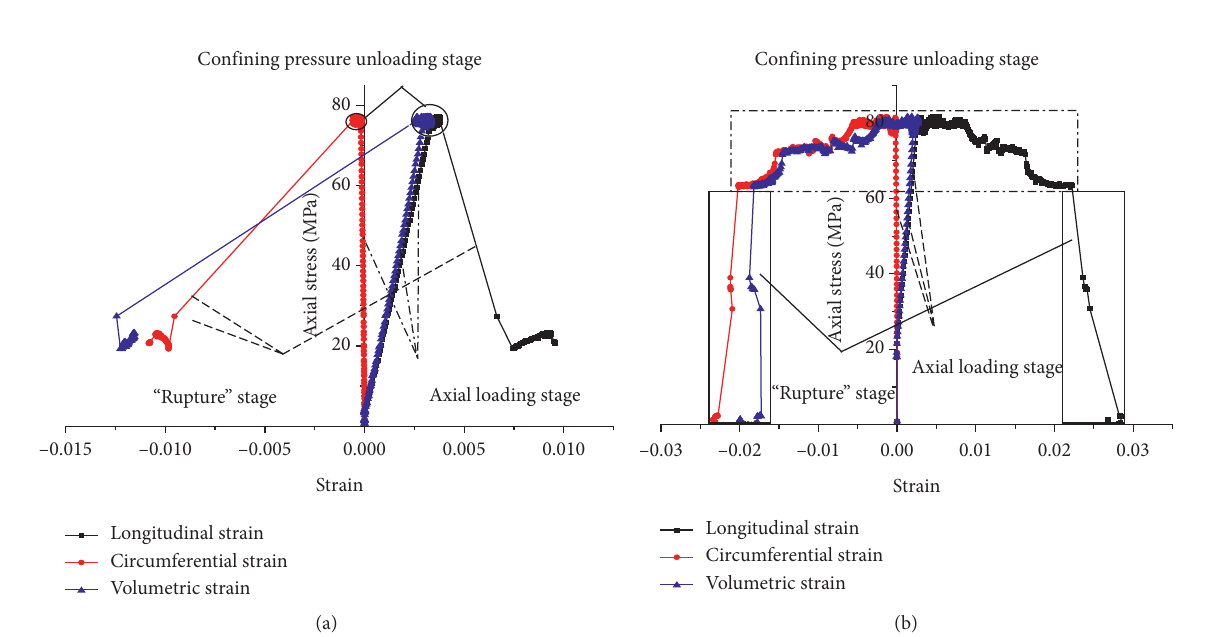
Figure 7: Axial stress versus strain curve for the mudstone specimens. (a) Depth � 200m. (b) Depth � 1000m.